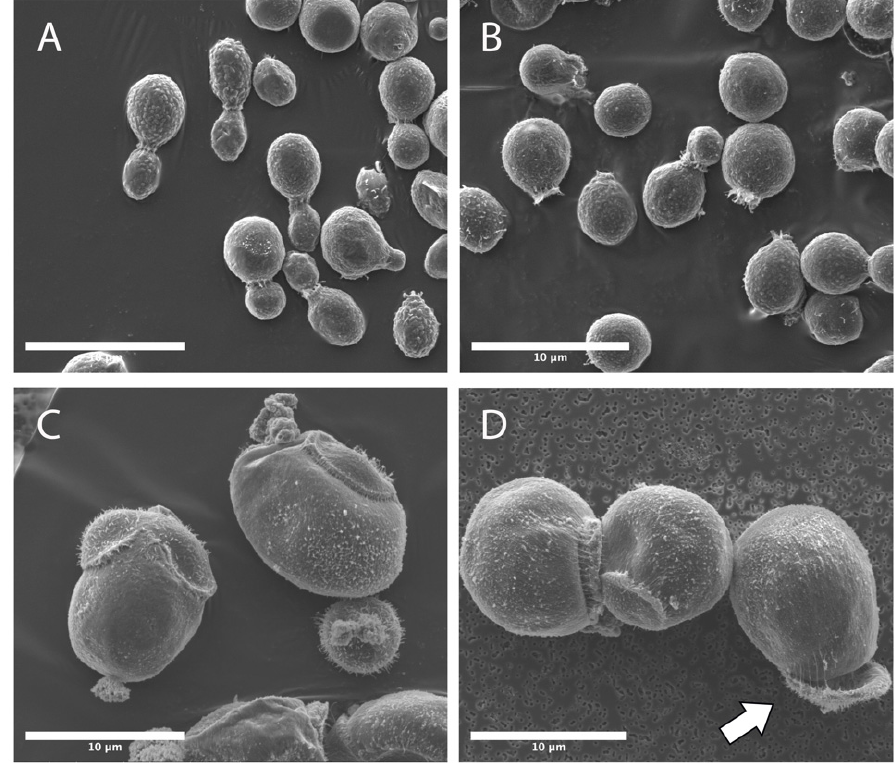
Figure 3. Analyses of scanning electron microscope (SEM) micrographs of SD, CO, and µG grown N. tulchinskyi cells demonstrated differences in conidia size, morphology, and daughter cell budding. SD ( A ) and CO ( B ) grown cells demonstrated similar standard yeast morphotypes, while µG ( C , D ) grown cells are larger, nonuniform in appearance, and exhibit random budding scars. In some instances, the µ G budding scars have raised centers, while others appear to be concave. Additionally, some budding scars appear to be shedding or peeling from the surface of the cells. This phenomenon is highlighted with the white arrow ( D ). Representative SEM micrographs are given, and scale bar for all micrographs is 10 µ